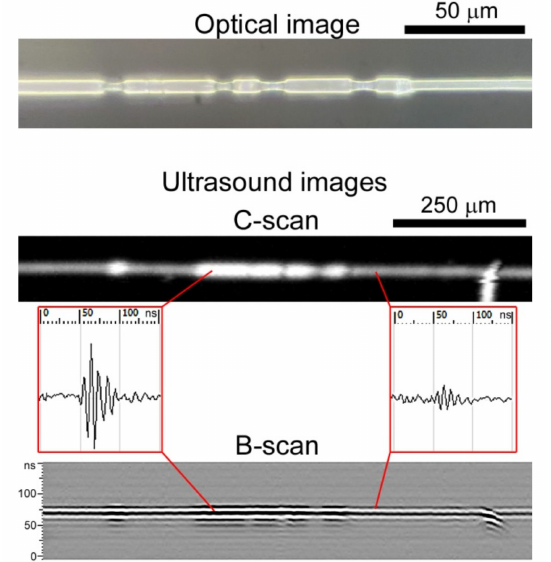
Figure 3. Visualization of a single stretched PLLA fiber using light microscopy and acoustic mi- croscopy. The original diameter of the fiber was 5 µ m. The thinned regions of the fiber generate a backscattered signal of lower amplitude in comparison with the original diameter, providing different observations of such regions in ultrasound images. Thin elongated fiber regions are dimly displayed. The field of view in the C-scan is 120 µ m × 1000 µ m (60 × 200 DPI). The B-scan was obtained from the fiber center. The microphotograph was obtained at the magnification of ×